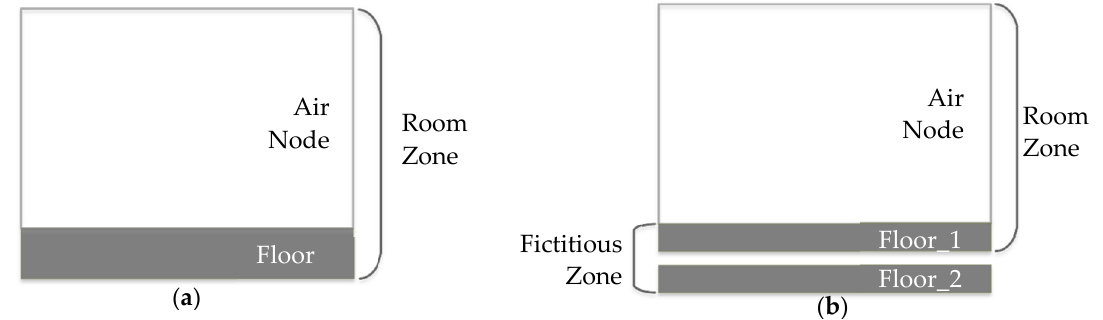
Figure 1. Conventional configuration of a room in TRNSYS ( a ); and configuration with the added fictitious zone in TRNSYS ( b ).